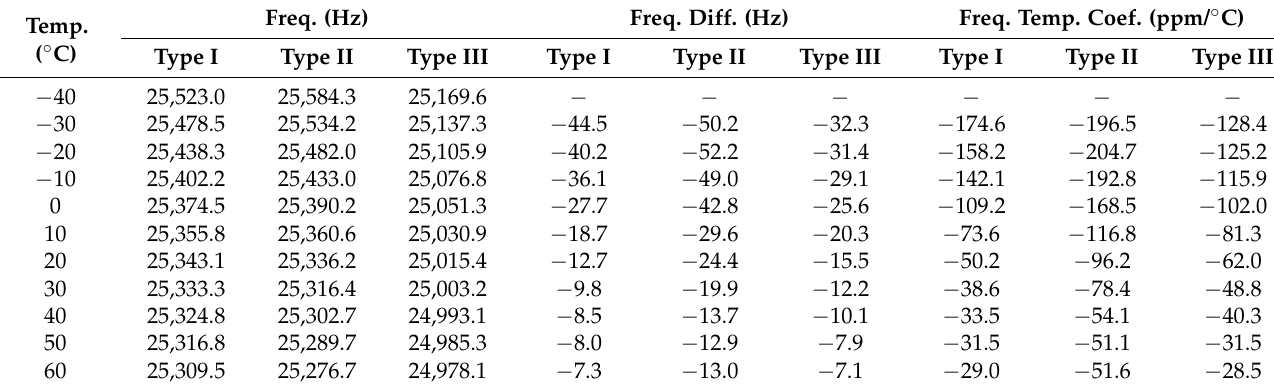
Table 3. The temperature characteristic test results of the resonator with hard adhesive (ABP 84-3JT).